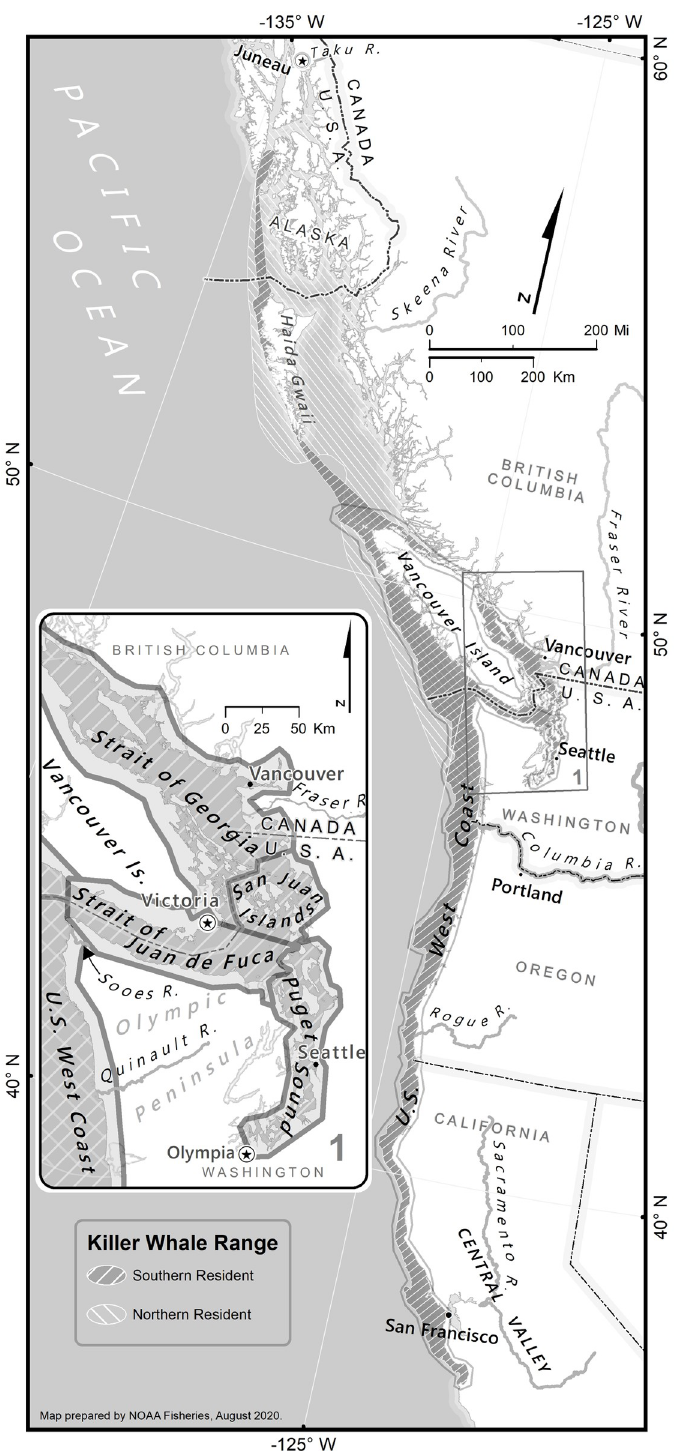
Fig 1. Ranges of Resident-type killer whales in the eastern north Pacific Ocean and study area for prey and fecal samples collected from Southern Resident killer whales between October and May from 2004 to 2017.